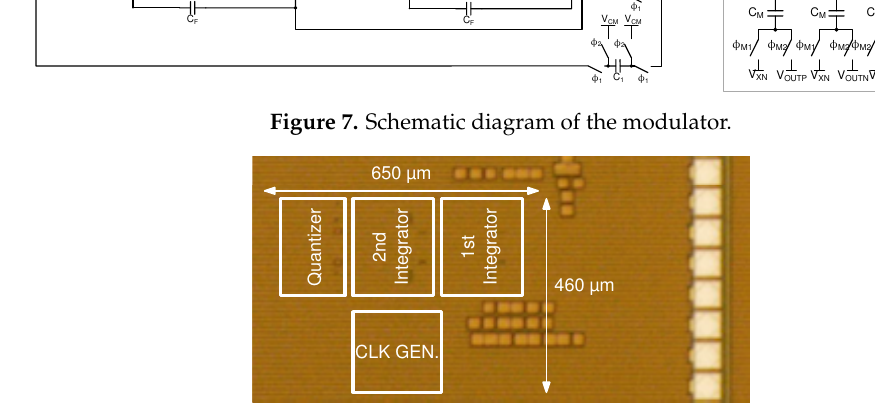
Figure 8. Chip micrograph. The core size is 650 µm × 460 µm.